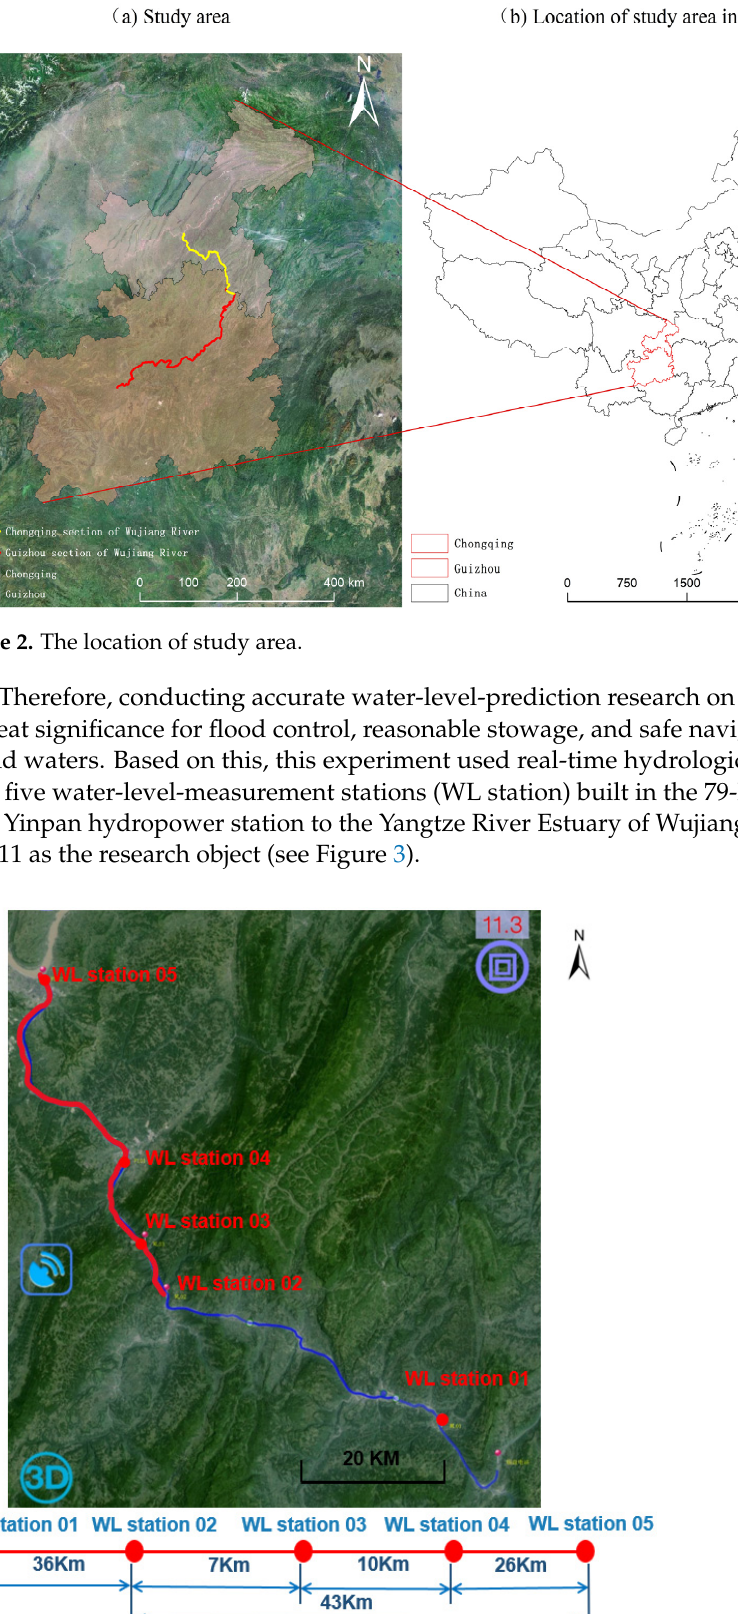
Figure 3. The distribution location of water-level-measurement stations.